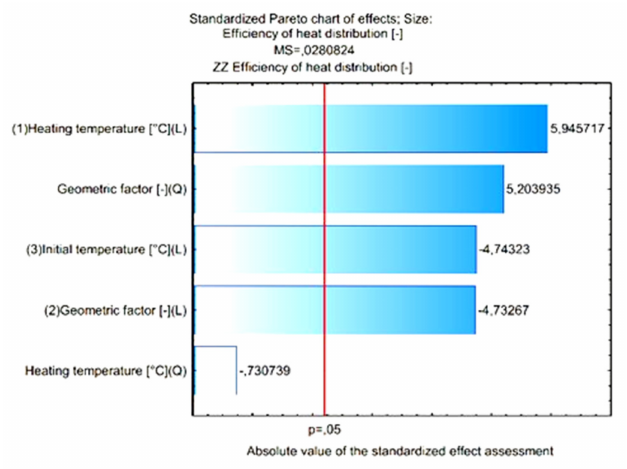
Figure 18. Pareto diagram of the influence of the analyzed input quantities and their correlationswith the value of the output expression, excluding insignificant